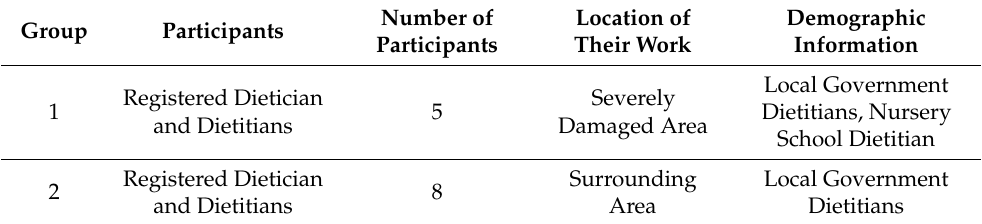
Table 1. Focus group interview